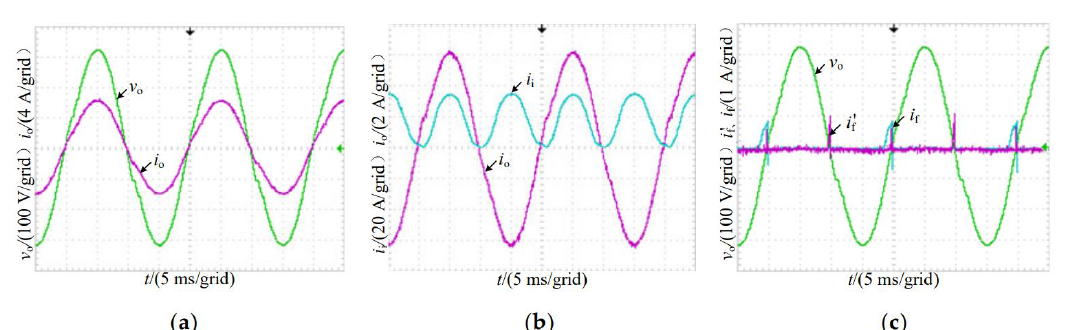
Figure 8. Experiment platform.